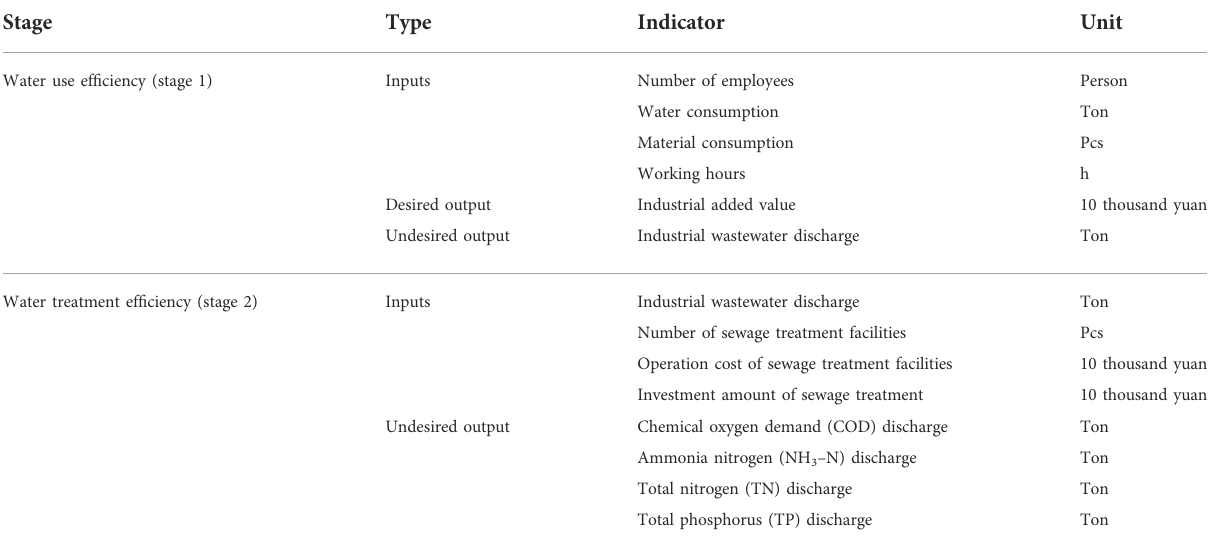
TABLE 1 Input and output indicators of the SBM – DEA